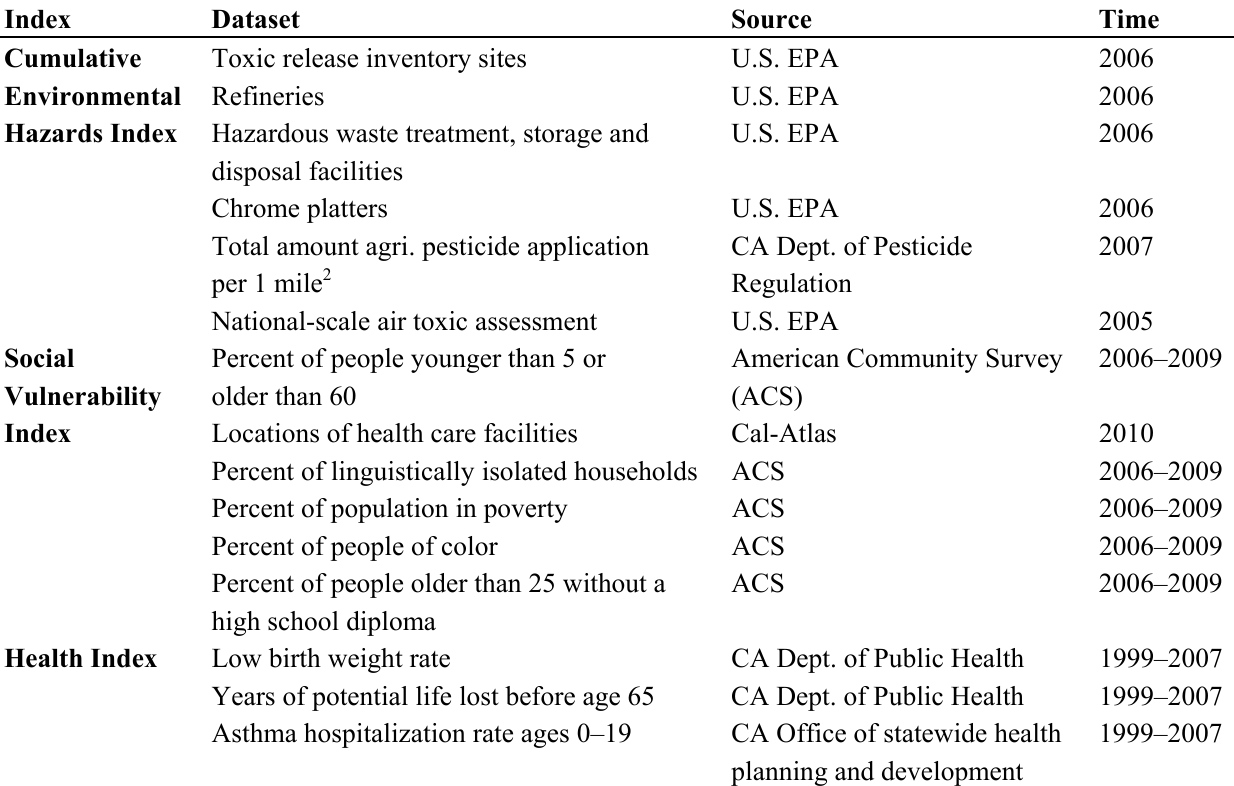
Table 1. Cumulative environmental hazards index, social vulnerability index and health